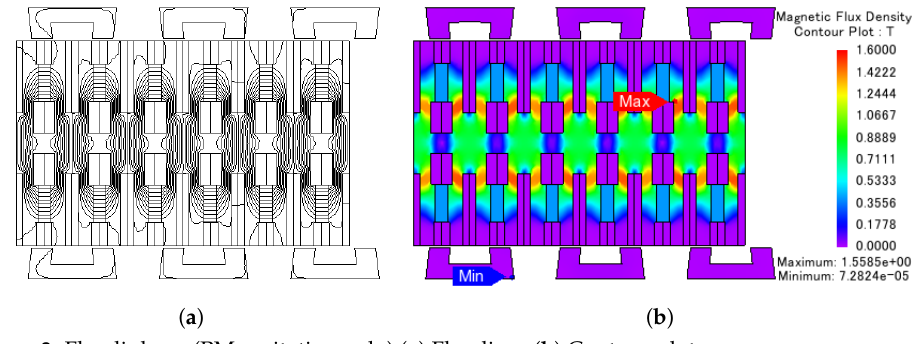
Figure 3. Flux linkage (PM excitation only) ( a ) Flux lines ( b ) Contour